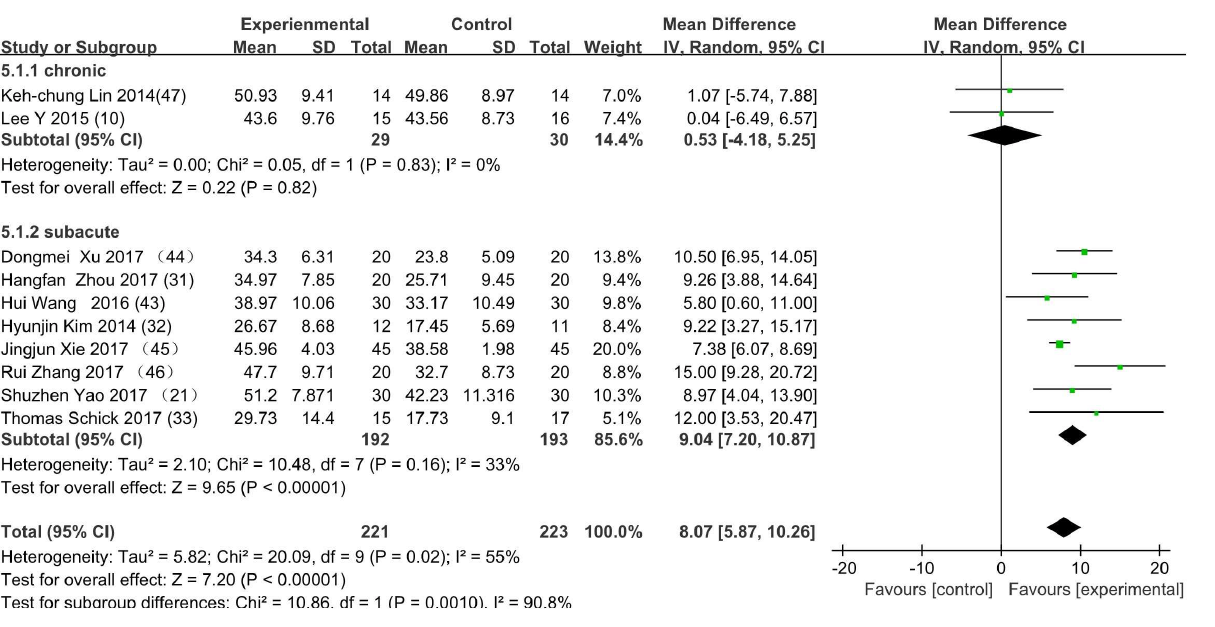
FIGURE 7 | Subgroup analysis for discriminating between subacute or chronic